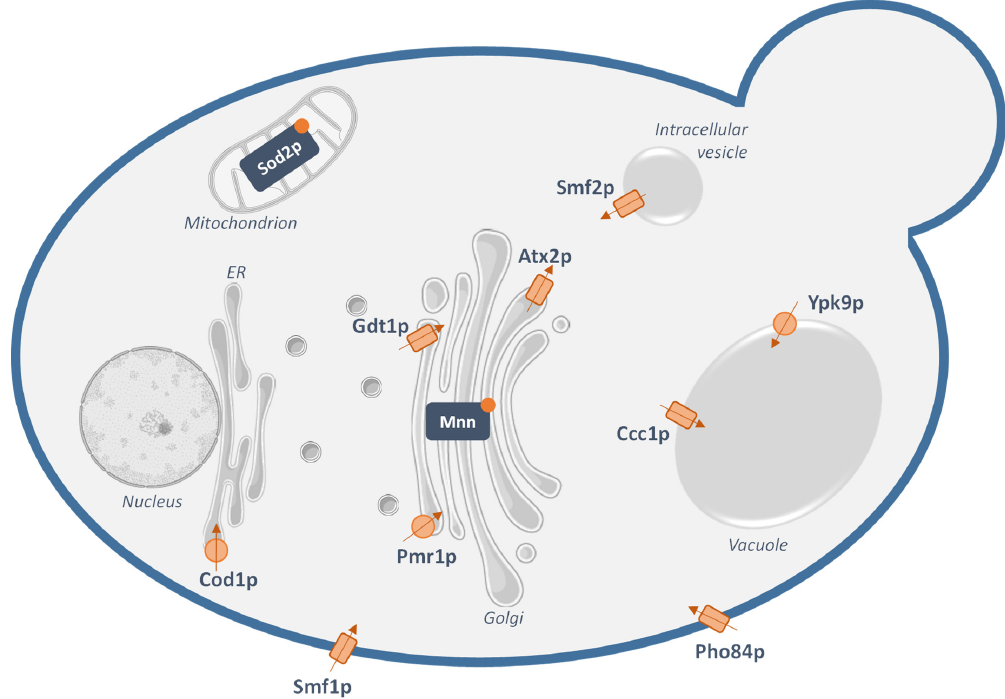
Figure 1. Suggested manganese transport pathways in the yeast Saccharomyces cerevisiae. The currently-identified yeast transporters proposed to transport Mn 2+ are: Smf1p, a plasma membrane Natural Resistance-Associated Macrophage Protein (NRAMP) transporter; Pho84p, a plasma membrane phosphate transporter that can transport Mn 2+ ; Pmr1p, a Golgi Ca 2+ and Mn 2+ -transporting P-type ATPase; Gdt1p, a Golgi Ca 2+ and Mn 2+ secondary transporter; Atx2p, a putative Mn 2+ transporter at the Golgi; Cod1p, a Mn 2+ -transporting P-type ATPase at the endoplasmic reticulum (ER); Smf2p, a NRAMP transporter that localizes in intracellular vesicles; Ypk9p, a P-type ATPase importing manganese in the vacuole; Ccc1p, a vacuolar Mn 2+ and Fe 2+ transporter. These transporters ensure proper maintenance of the manganese concentrations in the physiological range and activity of the Mn 2+ -dependent enzymes: the superoxide dismutase Sod2p in the mitochondrial matrix and mannosyltransferases (Mnn) in the Golgi lumen. The arrows represent the putative direction of transport of Mn 2+ , while the rectangles and circles correspond to secondary transporters and ATPases, respectively.